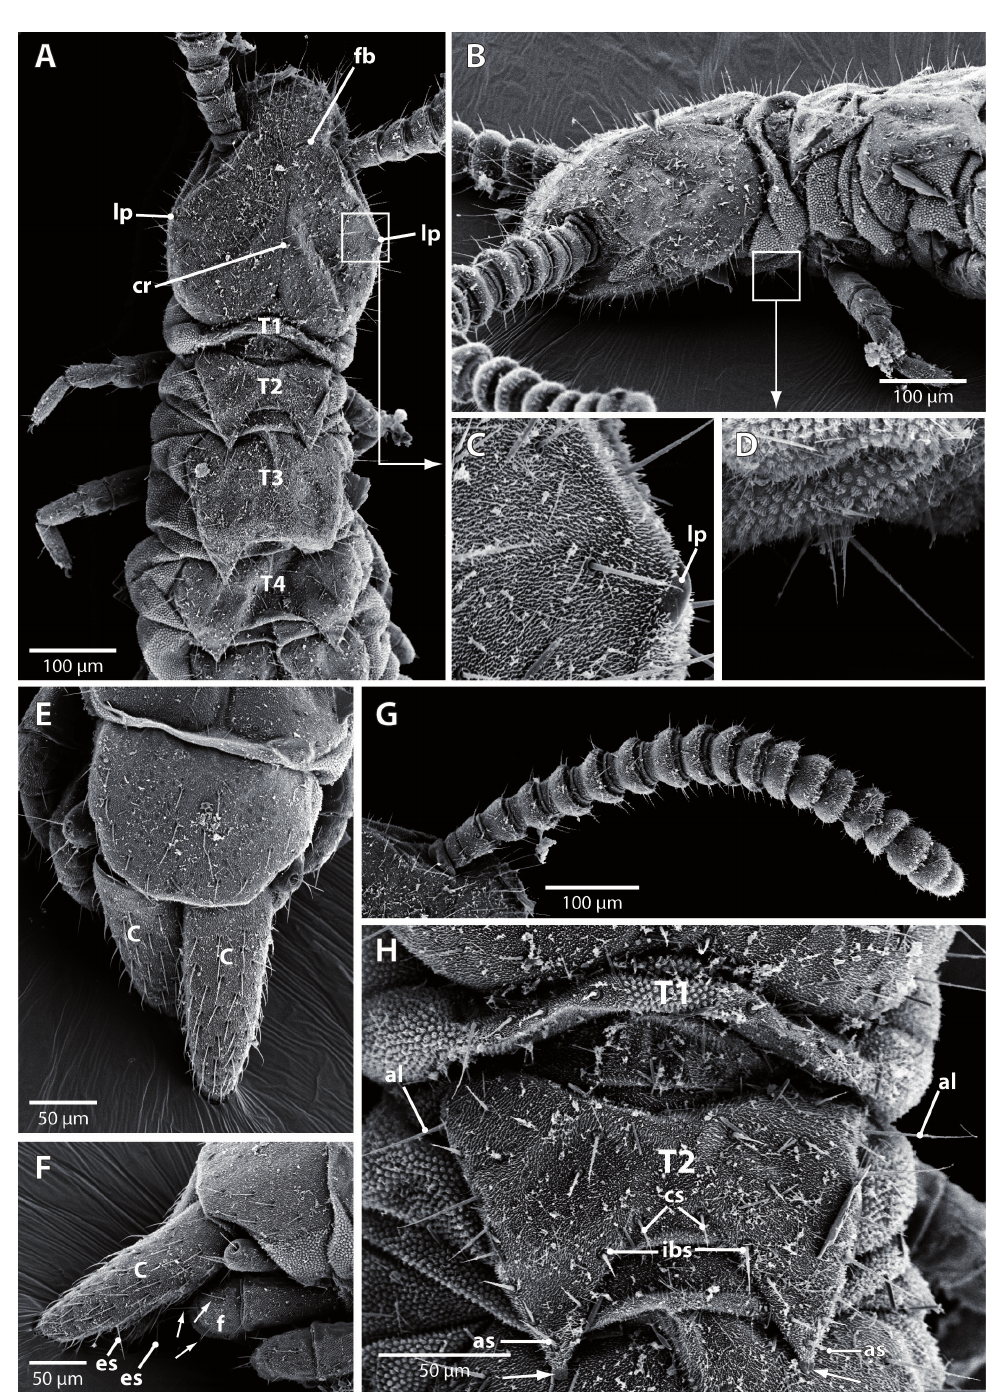
Fig. 2. Symphylella fuko sp. nov., holotype. A . Head and first 4 tergites ( T1, T2, T3, T4 ), dorsal view. Cr, central rod; fb, frontal branches; lp , lateral protuberance of head. B . Head and anterior part of trunk, lateral view. C . Detail of the surface of head and lateral protuberance of head ( lp ). D . Detail of first leg. E . Posterior part of trunk and cerci ( C ), dorsal view. F . Posterior part of trunk, last right legs and cerci ( C ), lateral view. Arrows , longer and erect setae of femur ( f ) of last leg; es, erect setae of ventral side of cerci. G . Left antenna. H . Detail of first ( T1 ) and second ( T2 ) tergites. Arrows, small end-swellings of triangular processes; al, anterolateral setae; as , apical setae; cs , central setae of the posteromarginal setae; ibs , inner basal setae of the posteromarginal